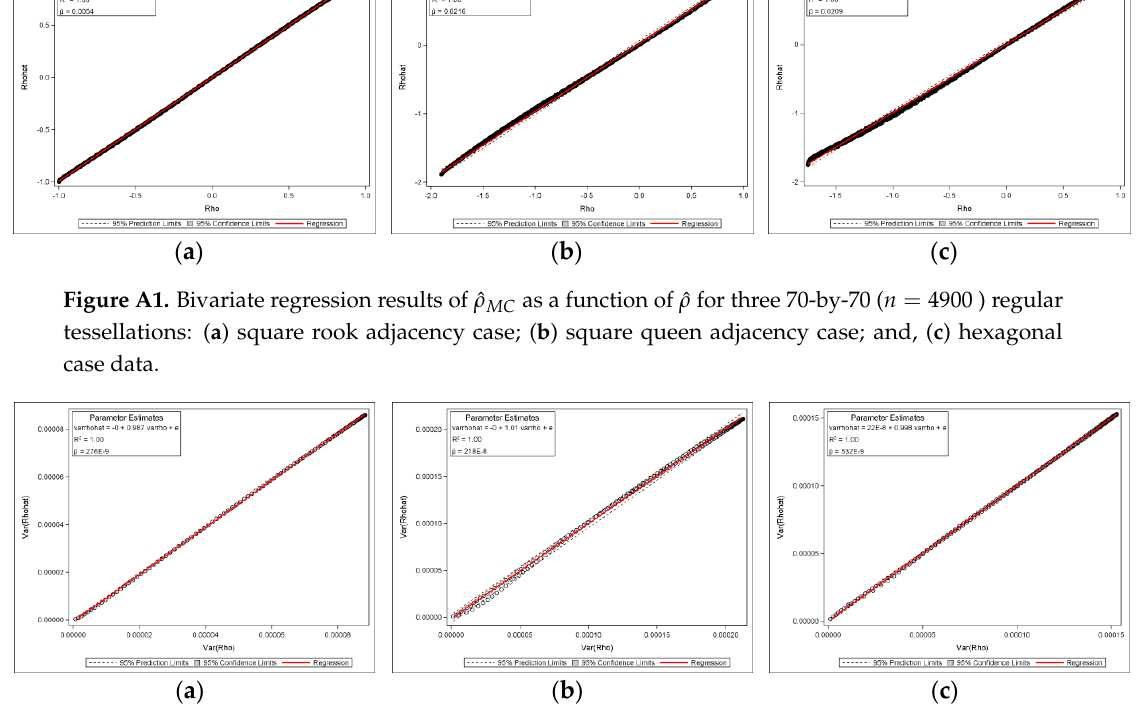
Figure A2. Bivariate regression results of the asymptotic variance of ˆ ρ as a function of its theoretical version for three 150-by-150 ( n = 22,500 ) regular tessellations: ( a ) square rook adjacency case; ( b ) square queen adjacency case; and, ( c ) hexagonal case.